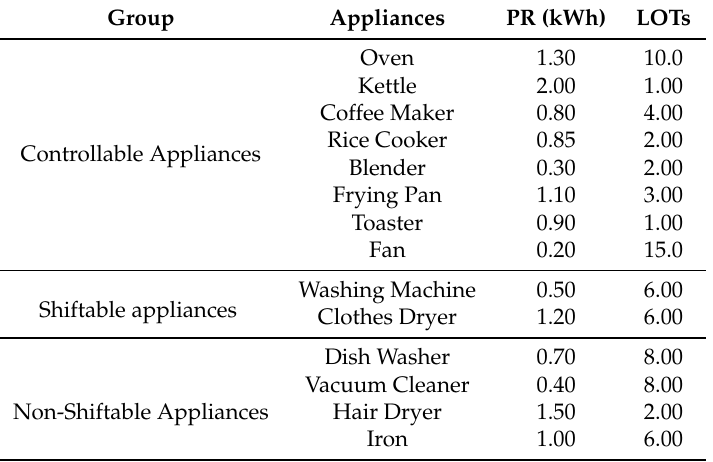
Table 3. Power rating and length of operational time for operational time interval 20 min.